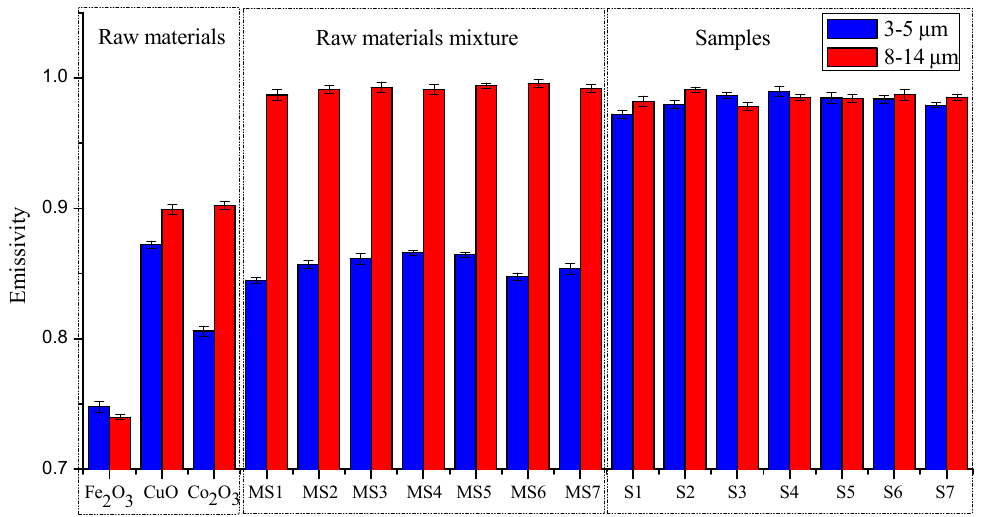
Figure 4. Emissivities of various formulas in 3–5 and 8–14 μ m